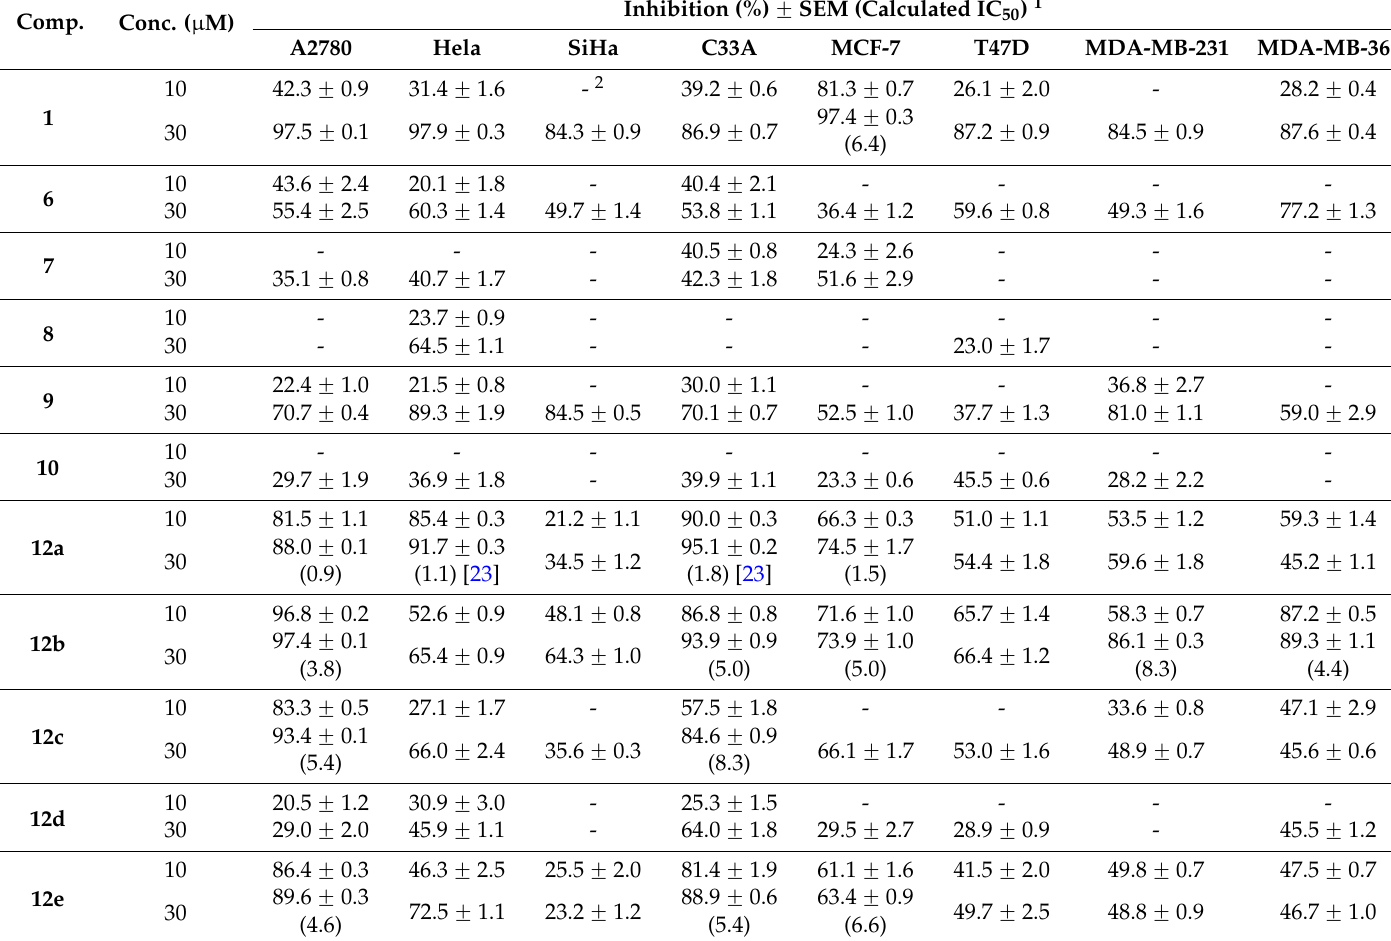
Table 1. Antiproliferative properties of the synthesized compounds. Mean value from two independent determinations with five parallel wells; standard deviation <15%.